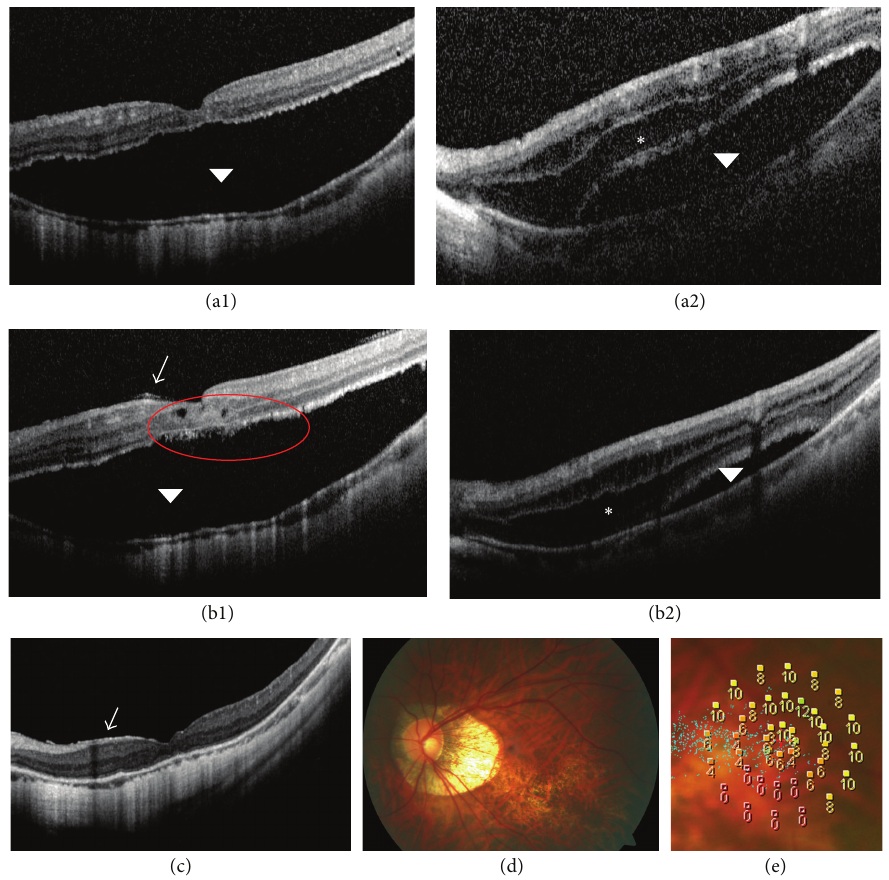
Figure 4: OCT findings in Case 3 during follow-up. (a1) Baseline OCT of the left eye (OS) reveals foveal detachment (arrowhead). (a2) Baseline OS OCT taken superior to the fovea reveals macular retinoschisis (asterisk) and foveal detachment (arrowhead). (b1)-(b2) OS OCT 1 month later reveals that the foveal detachment has reduced, photoreceptor layer is discontinuous (red circle), and retinoschisis has increased in the region superior to the fovea. A thin flat membrane (arrow) is evident. (c) At 44 months, OS OCT reveals that retinal traction has spontaneously resolved. (d) OS fundus photograph taken 44 months later depicts some atrophy in the inferior macula. (e) At 44 months, OS microperimetric image reveals that the retinal sensitivity was 6.30 dB and that fixation was